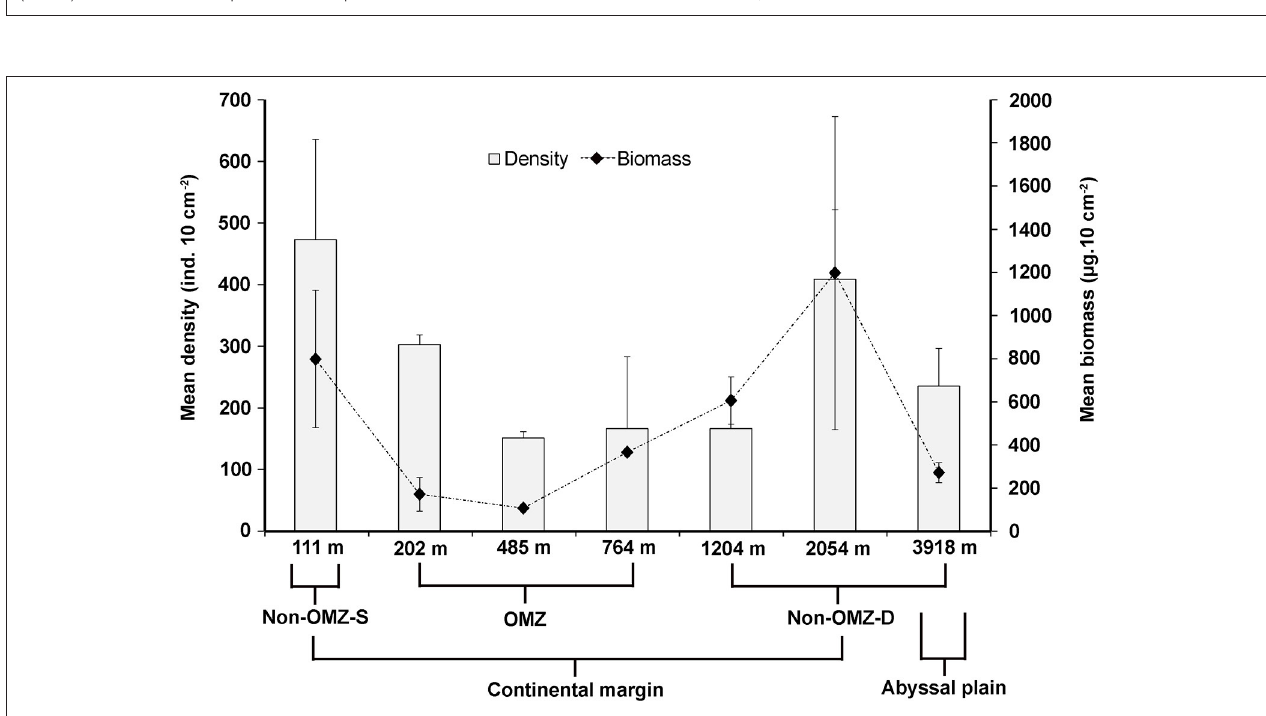
FIGURE 3 | Distribution of total meiofaunal density, and biomass (mean ± SD) in the sediment (0–10cm) along the depth gradient of WICM.